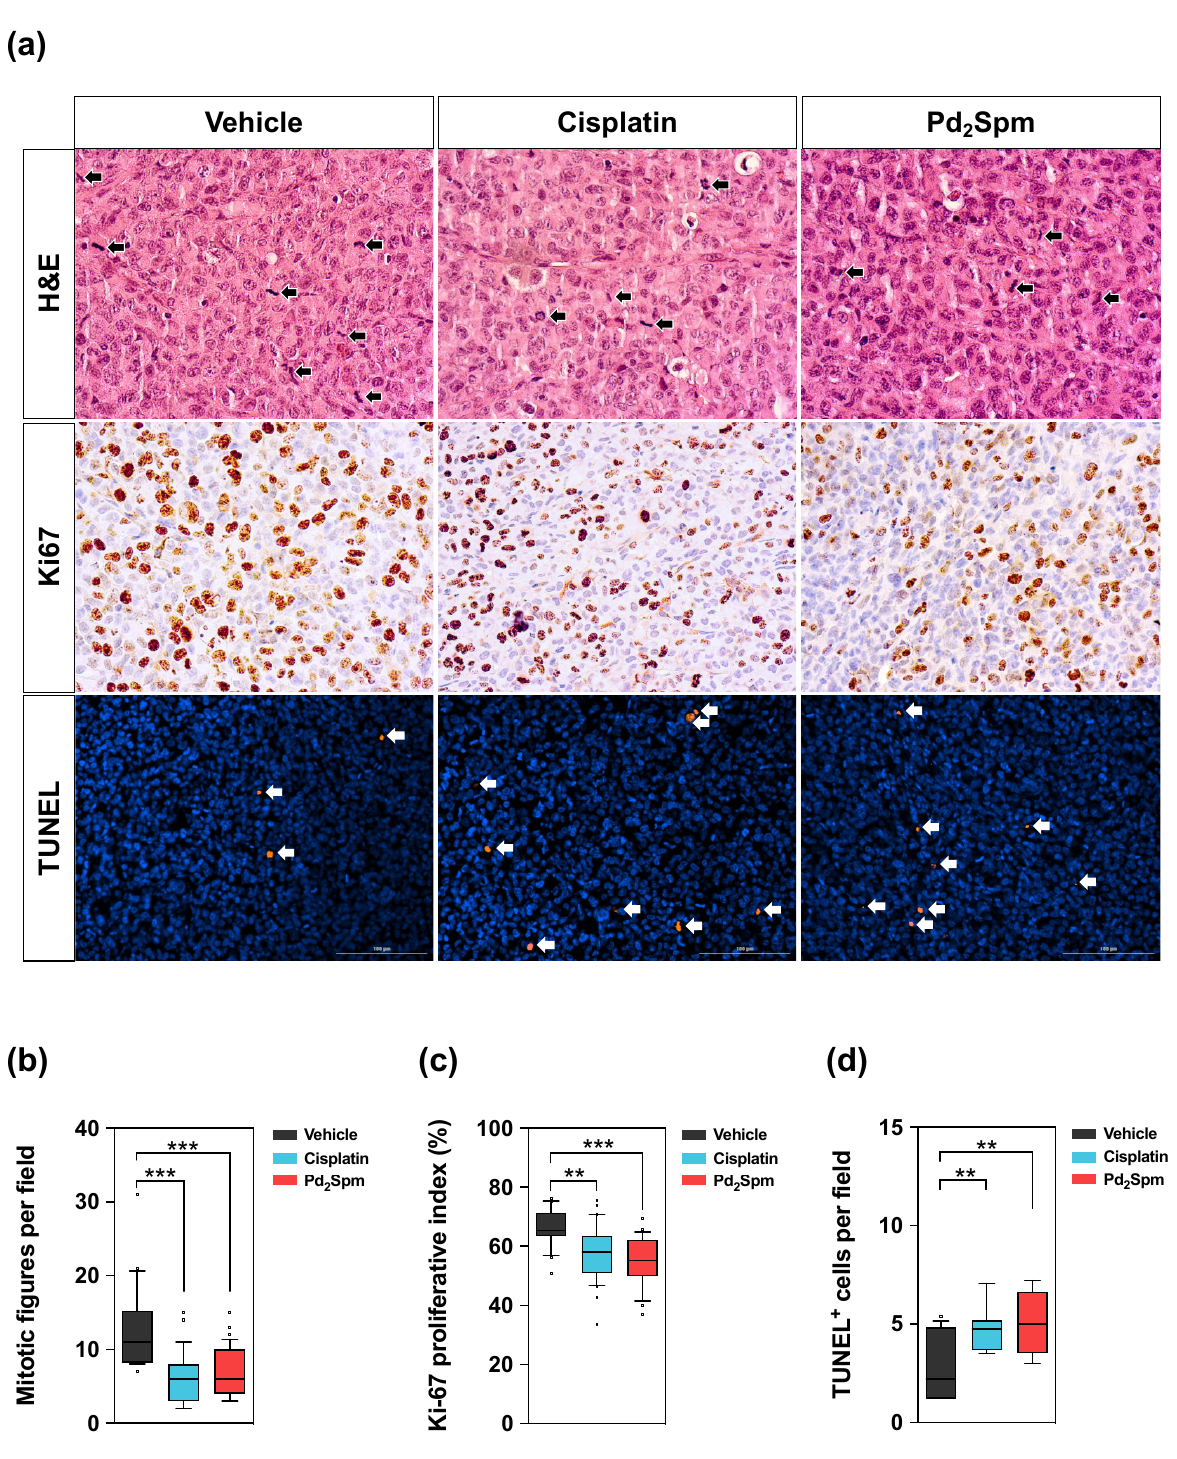
Figure 4. ( a ) Representative micrographs of MDA-MB-231 breast cancer tumors stained with hematoxylin–eosin (H&E, black arrows show mitotic figures), Ki-67 nuclear staining and TUNEL assay staining (white arrows show TUNEL positive cells). ( b ) Quantitative analysis of mitotic figures. ( c ) Quantitative analysis of Ki-67 proliferative index. ( d ) Quantitative analysis of TUNEL-positive cells. Data are shown as box plots with medians analyzed with Kruskal–Wallis test followed by Dunn’s multiple comparisons test. ** p < 0.01, *** p < 0.001. Five random fields per tumor with at least 600 cells/field were analyzed. Scale bar = 100 µm. Pd 2 Spm 5 mg/kg/day ( n = 7), cisplatin 2 mg/kg/day ( n = 7), vehicle ( n = 5).